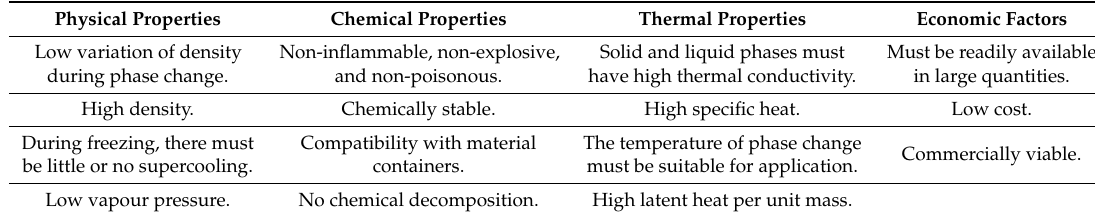
Table 1. Desirable Characteristics of Phase Change Materials (PCMs)